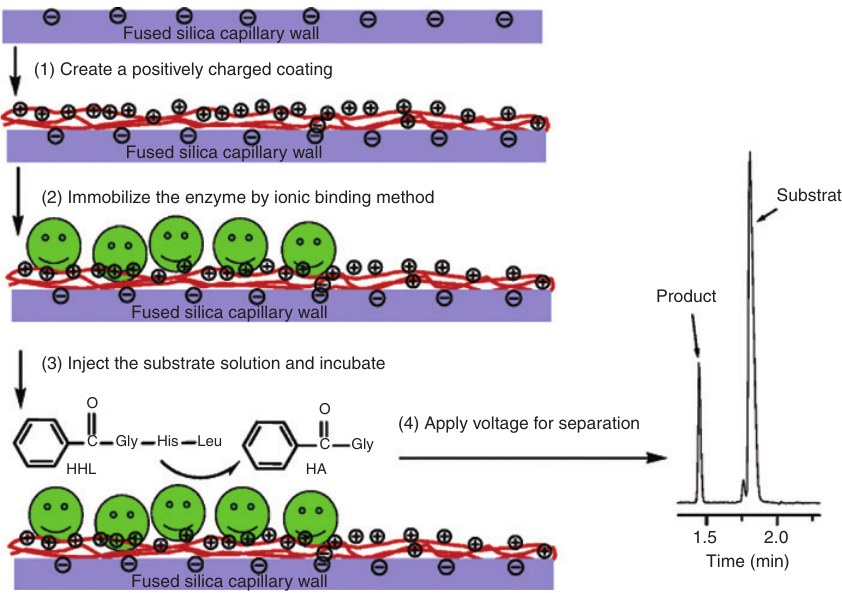
Figure 1: Schematic representation of the on-column immobilized enzyme microreactor prepared by the ionic binding method. This figure was reproduced with permission from Tang and Kang (2006). Copyright © 2006 American Chemical